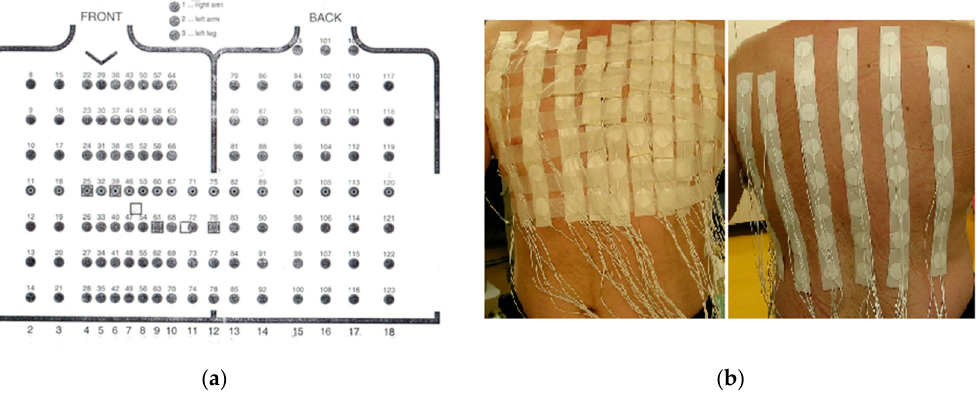
Figure 1. ( a ) A total of 120 electrodes of the Biosemi system grid, ( b ) example of the electrodes’ placement on the chest (on left) and the back (on right) of a